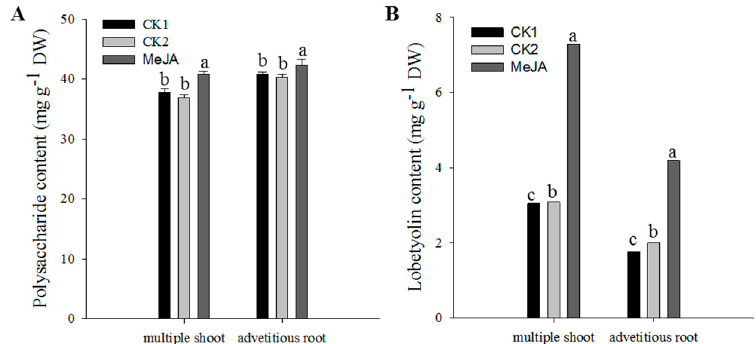
Figure 4. Effect of MeJA on the accumulation of polysaccharide ( A ) and lobetyolin ( B ) in multiple shoots using the adventitious root as the reference. CK1, blank control; CK2, solvent control. Statistically significant differences between the means were determined using Fisher’s LSD test p < 0.05) and indicated with different lowercase letters.